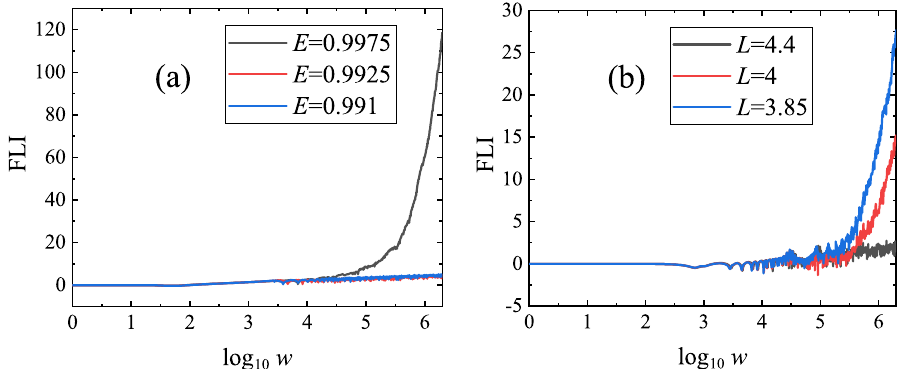
Figure 4. Fast Lyapunov indicators (FLIs). ( a ) The initial separation is r = 15; the other initial conditions and parameters are those of Figure 2. The FLIs for E = 0.991 and E = 0.9925 correspond to the regular behavior, but the FLI for E = 0.9975 shows the chaotic behavior. ( b ) The initial separation is r = 70; the other initial conditions and parameters are those of Figure 3. The FLI for L = 4.4 indicates the regularity. L = 3.85 corresponds to stronger chaos than L =